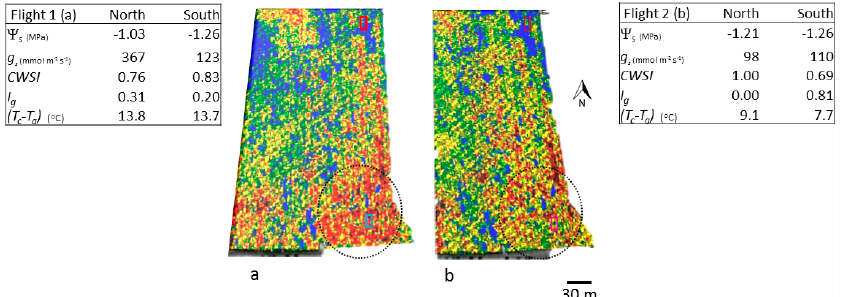
Figure 6. Comparison of vine water status of SHI at veraison ( a ) and pre-harvest ( b ) in 2016 using remotely sensed thermal images colour coded to temperature. Colour codes of relative values: blue/green=low/no water stress, yellow/red = moderate water stress. Data presented in the tables above is for the positions marked on the maps and indicates the proximity of the vines used for ground-truthing. Flight 1: vine water status differed between northern and southern sections of the block, which was the consequence of blocked irrigation lines in the southern section of the block ( a ). Flight 2: remediation of irrigation lines before the pre-harvest flight resulted in a more uniform application of water and consequent reduction in vine water status variability ( b ).